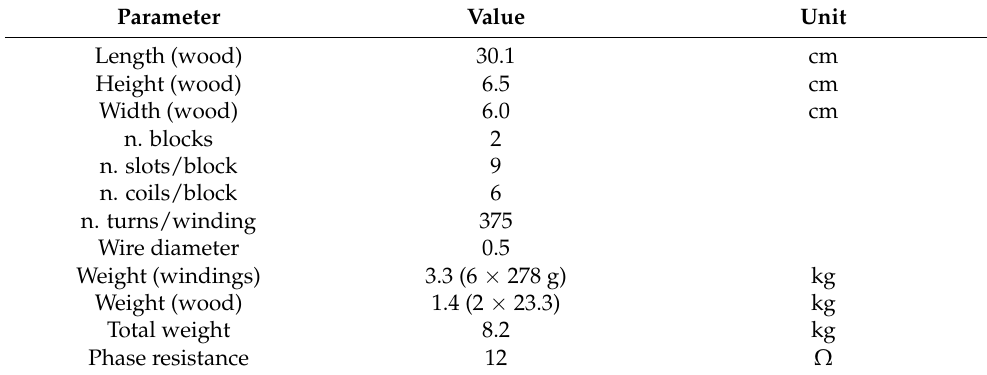
Table 2. Specifics of the ironless stator.